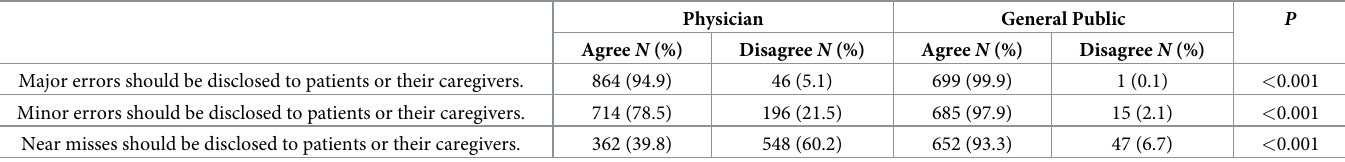
Table 2. Perceptions of DPSI according to the level of harm resulting from medical errors.